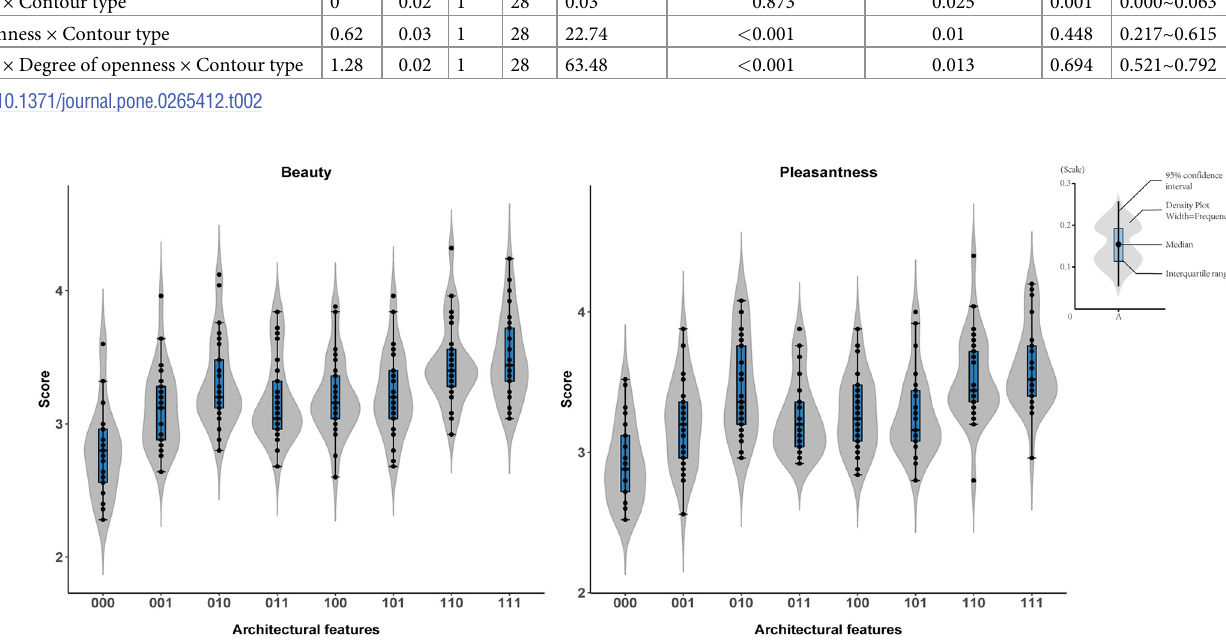
the beauty and pleasantness rating. For architectural space with lower ceilings and less open space, curvilinear contours were rated higher than rectilinear contours (p < 0.05). In the com- bination of lower ceilings and more open space, rectilinear contours were more likely to lead to a high beauty and pleasantness score (p < 0.05). When buildings have lower ceilings and